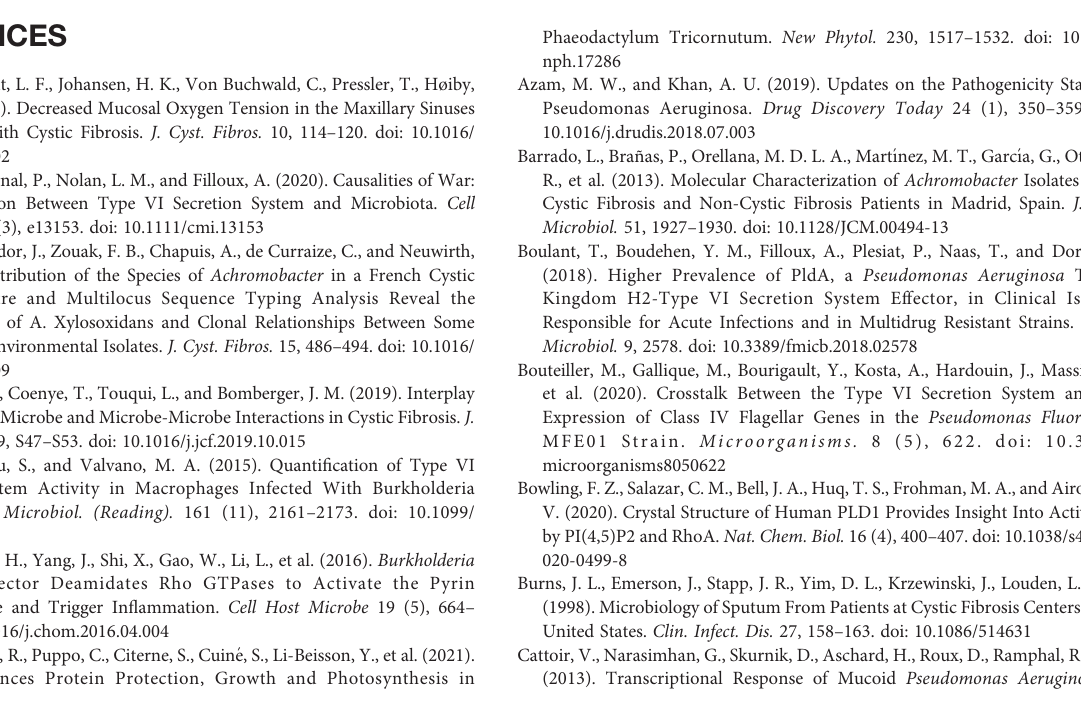
Supplementary Figure 2 | Growth curves of A8 and A8 D tssL. Three independent cultures ofA8 strain (black) andA8 D tssL (gray) weregrownin LB (solid